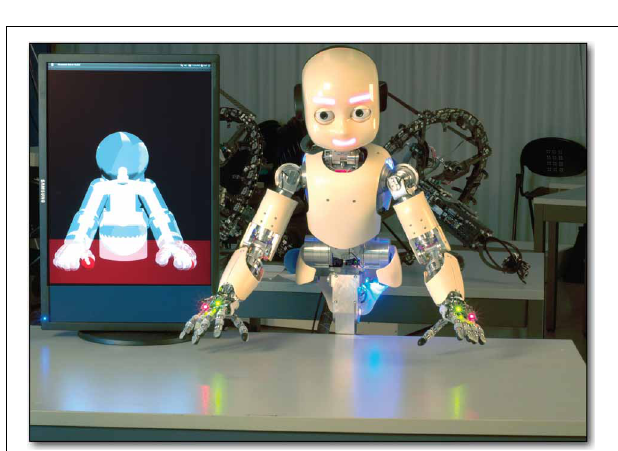
collide with one another (shown in red), they generate repulsive, constraint forces, which in this case push the hands away from the table surface.